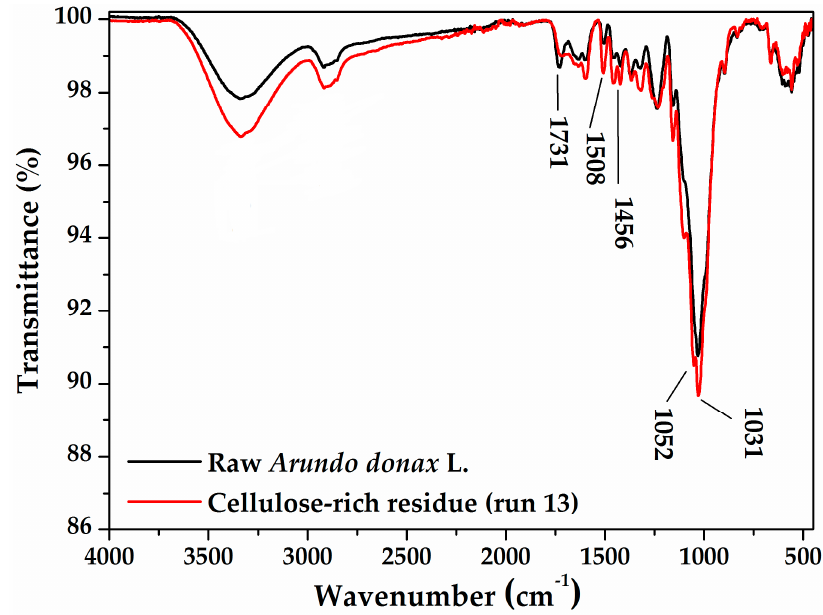
Figure 4. FT-IR spectra of the starting raw Arundo donax L. (black) and the cellulose-rich residue recovered from run 13 (red).